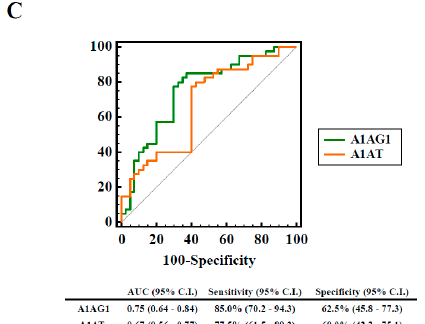
Figure 1. Protein levels of A1AG1 and A1AT in serum were examined using anti-A1AG1 ( A ) and anti-A1AT ( B ) antibodies through Western blotting. Average blot densitometric values were calculated from duplicate data. Percentages of sodium dodecyl sulfate polyacrylamide gel electrophoresis (SDS-PAGE) gel and loading amounts of serum proteins used in Western blotting were 10% and 2 μ g for A1AG1, and 8% and 2 μ g for A1AT, respectively. A duplicate gel was stained with Coomassie brilliant blue (CBB) as a loading control (right, bottom panel). The red arrow indicates the A1AG1 or A1AT protein. Receiver operating characteristic (ROC) curves were generated according to blot densitometry of A1AG1 and A1AT. The area under the ROC curve (AUC), sensitivity, and specificity were further estimated ( C ).